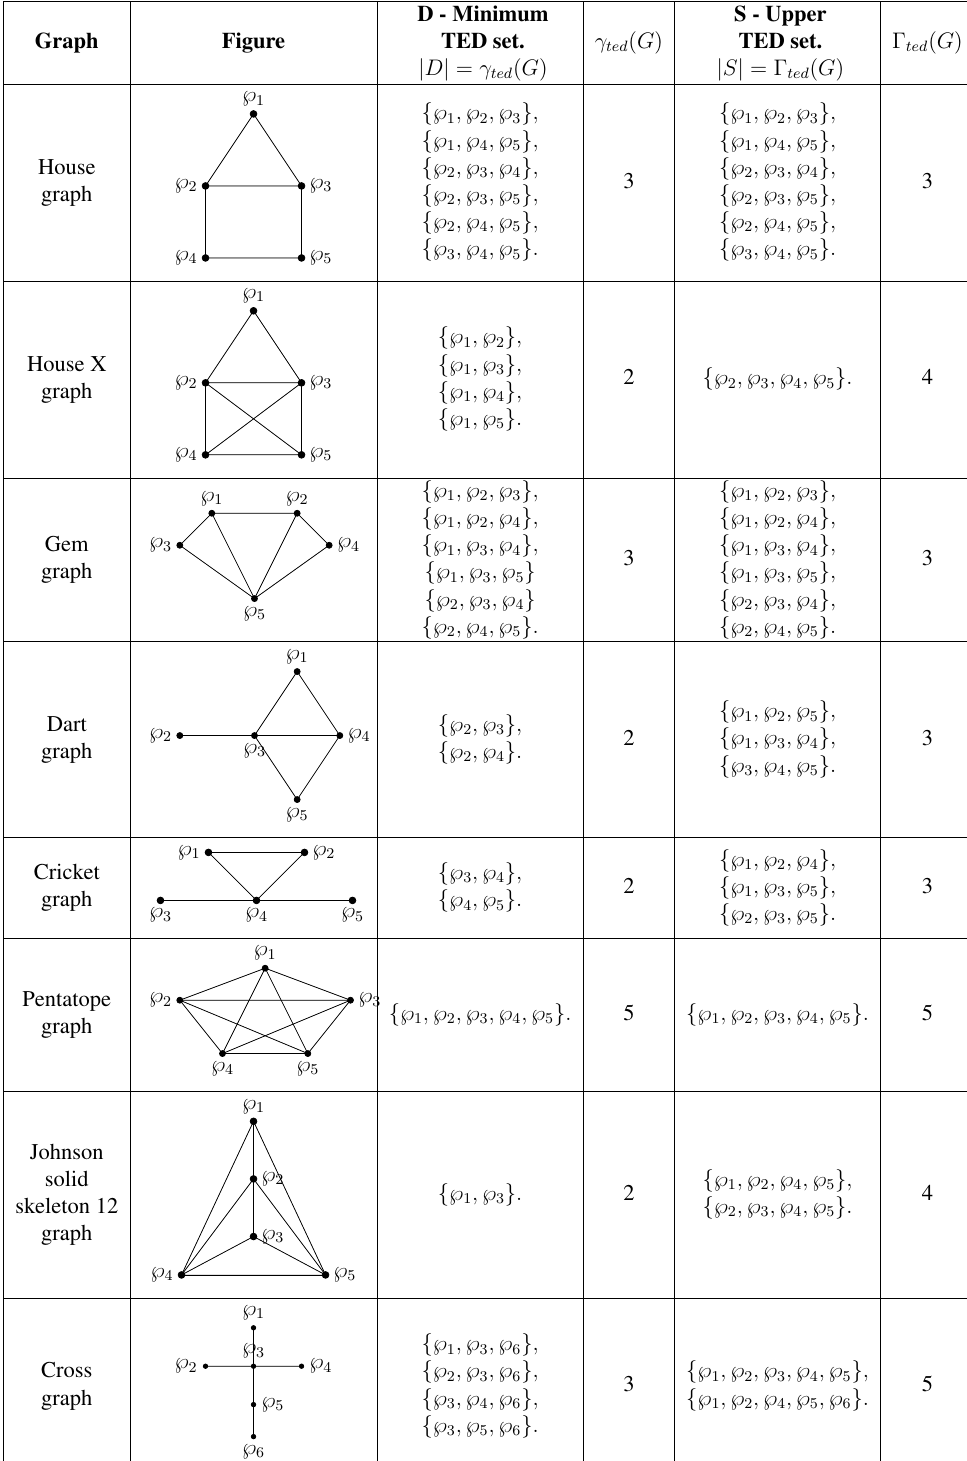
D - Minimum TED set. TED